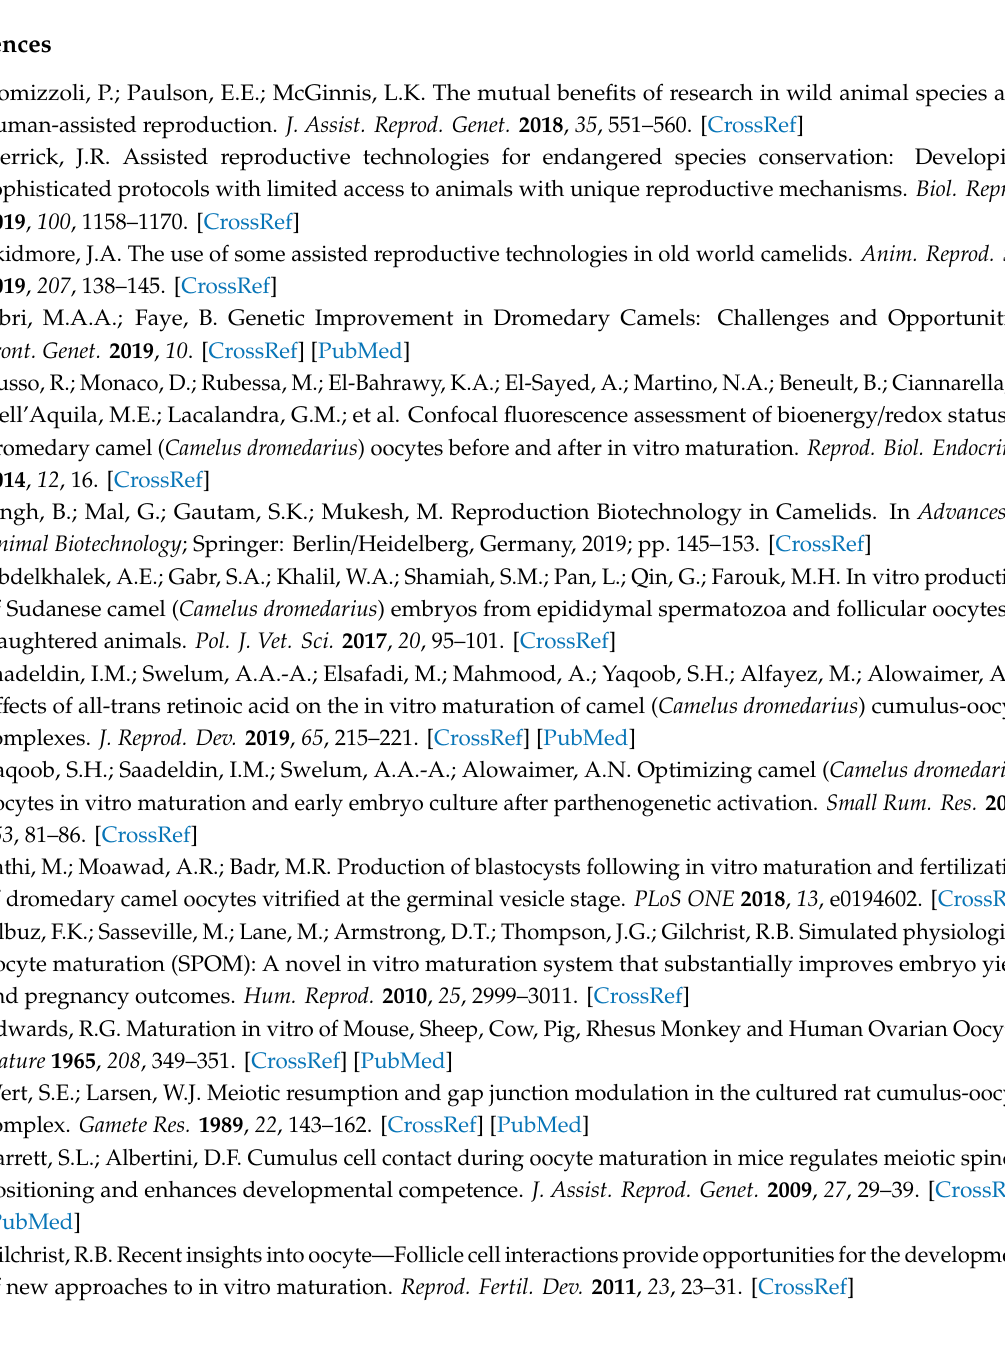
Figure S1: Camel oocyte morphometry parameters. Figure S2. E ff ect of short-term supplementation on cumulus morphology of